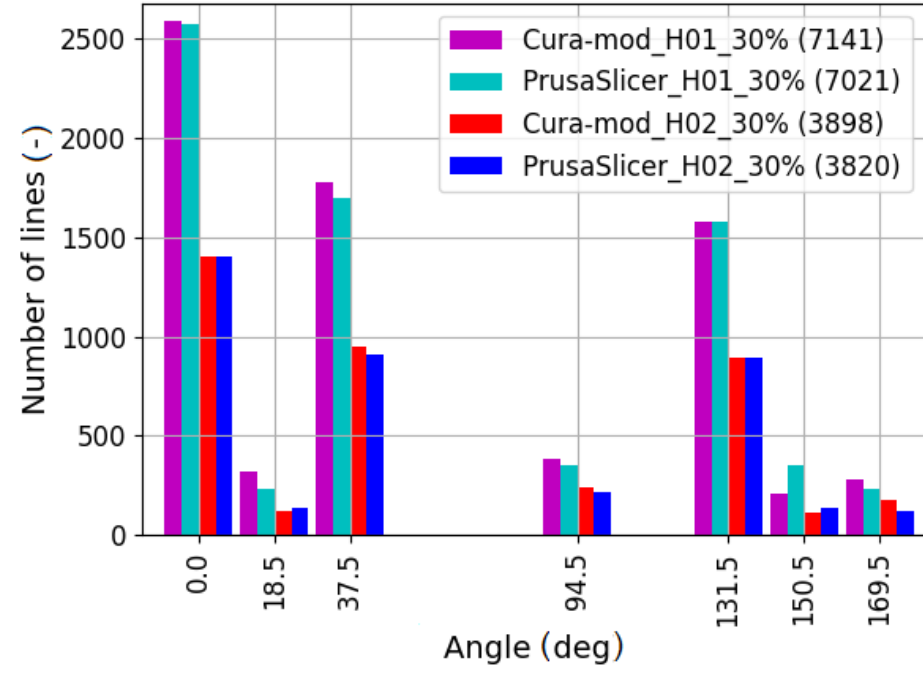
Figure 11. Variation of the line slopes.